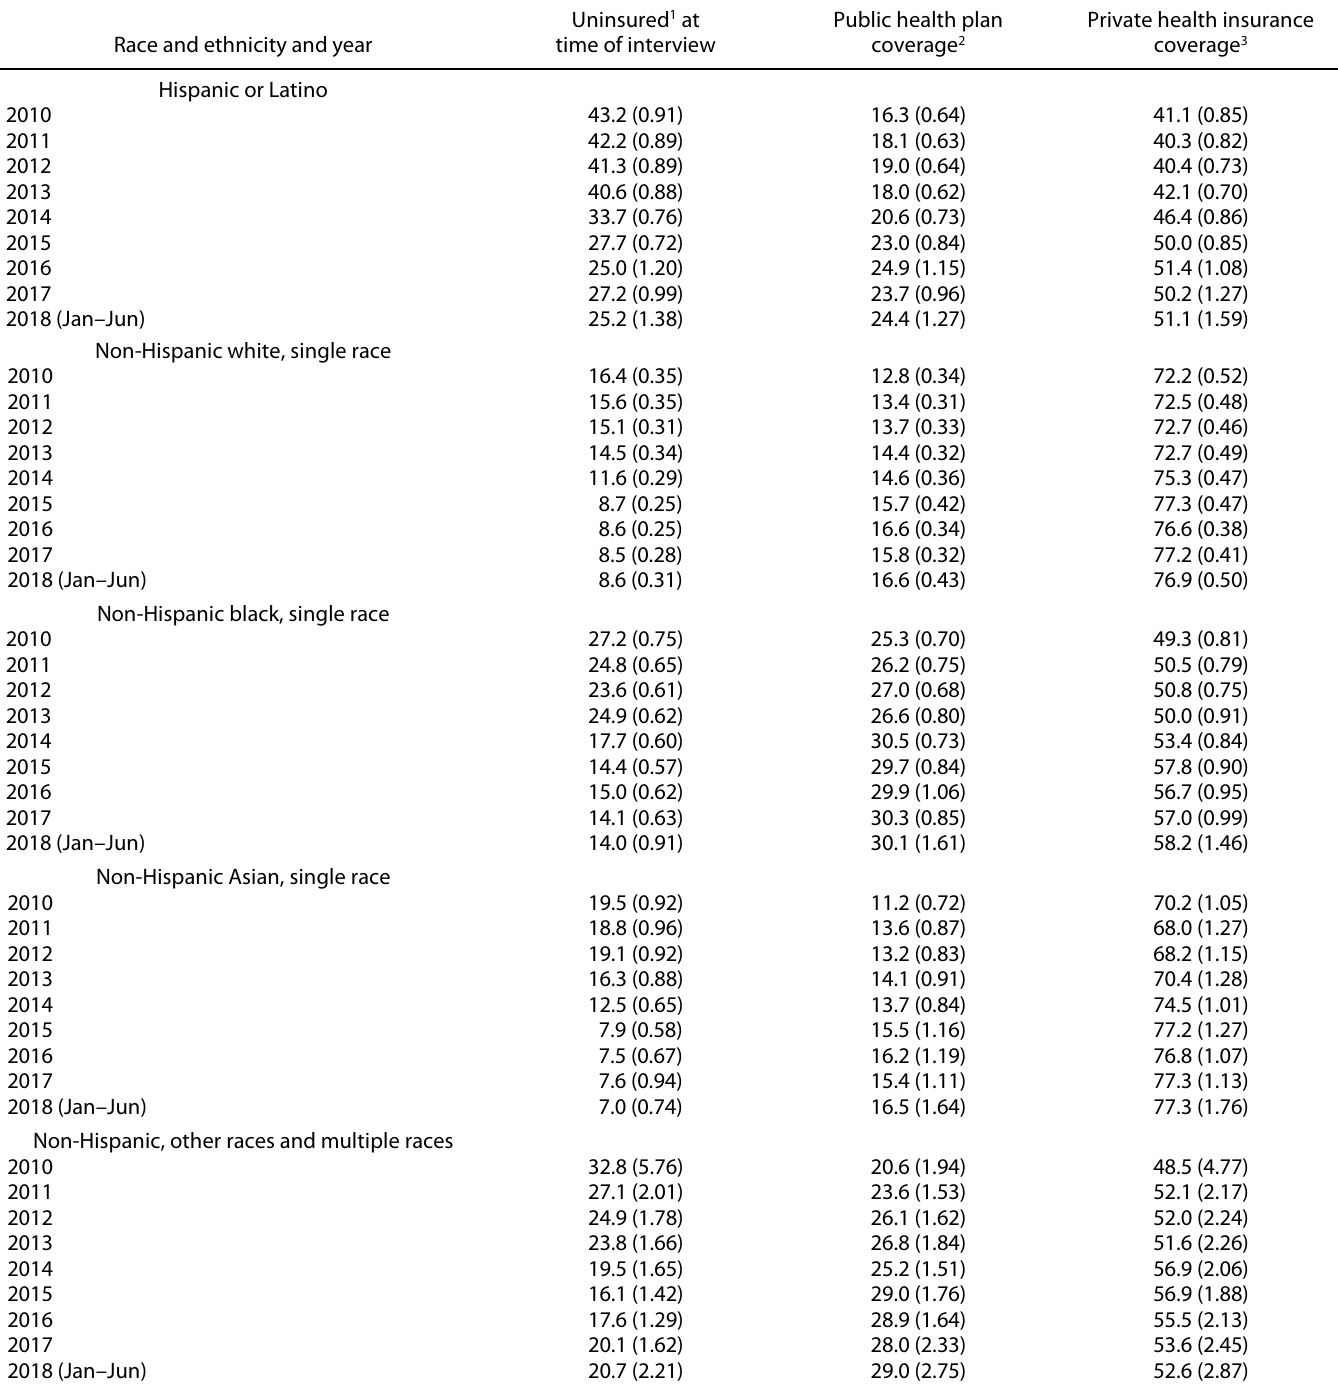
Table IX. Percentages (and standard errors) of adults aged 18–64 who lacked health insurance coverage, had public health plan coverage, and had private health insurance coverage at the time of interview, by race and ethnicity and year: United